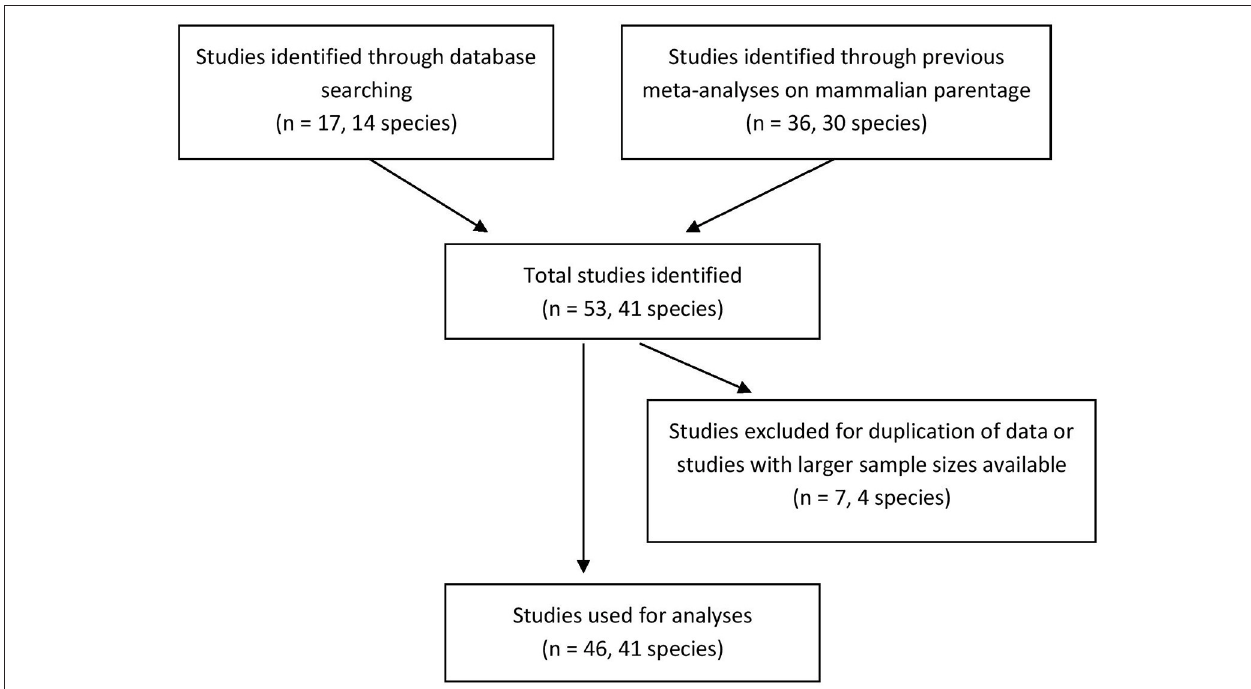
FIGURE 1 | Flow chart for the literature search for studies of socially monogamous mammals with genetic parentage data. Sample sizes presented are the numbers of studies found.